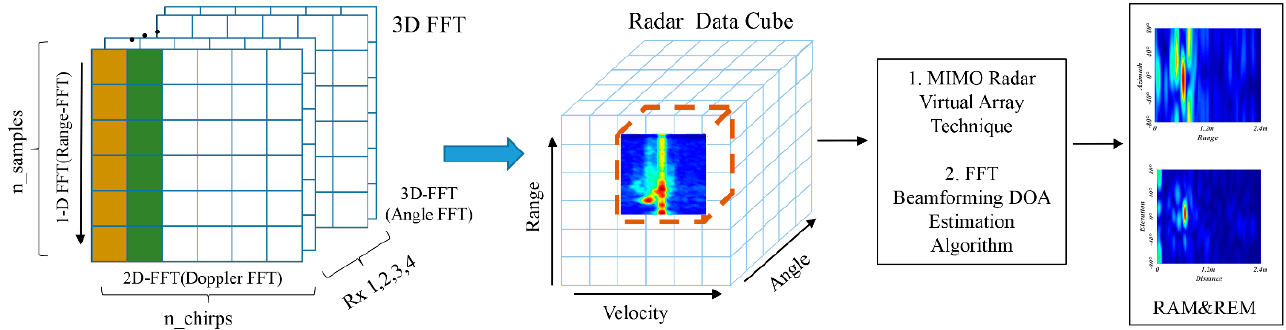
Figure 6. The generation process of RAM and REM.